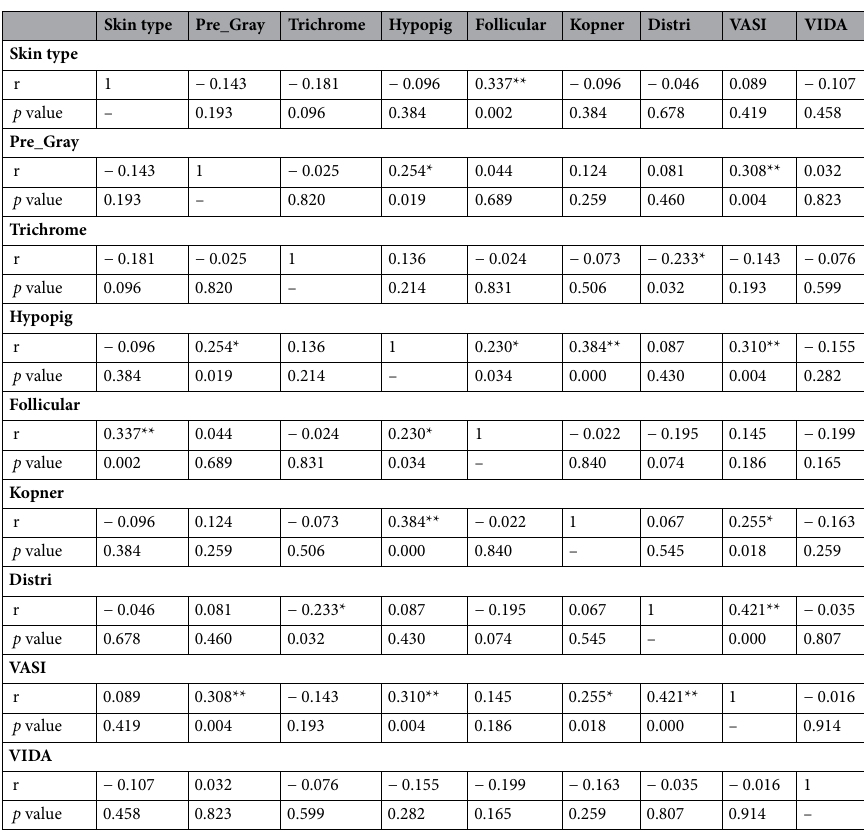
Table 8. Correlation analysis of vitiligo clinical characteristics in the study. Spearman’s Correlation coefficient are presented for different clinical characteristics among vitiligo patients’ understudy. Significant values are highlighted. **Correlation is significant at the 0.01 level (2-tailed). *Correlation is significant at the 0.05 level (2-tailed). Distri. distribution, Pre_Gray: pre greying, VASI vitiligo area severity index, VIDA vitiligo disease activity